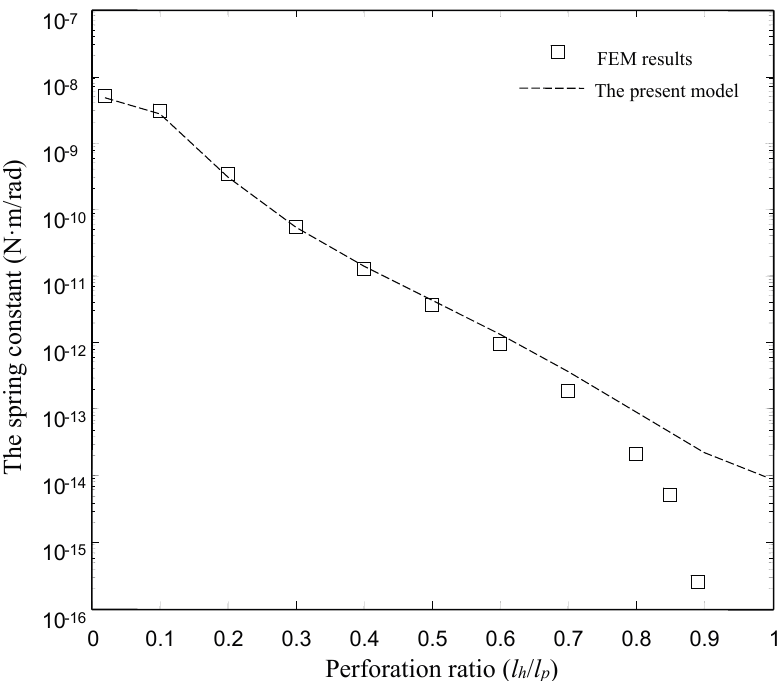
Figure 12. Comparison of the spring constant of the type II devices obtained by the FEM model and the present